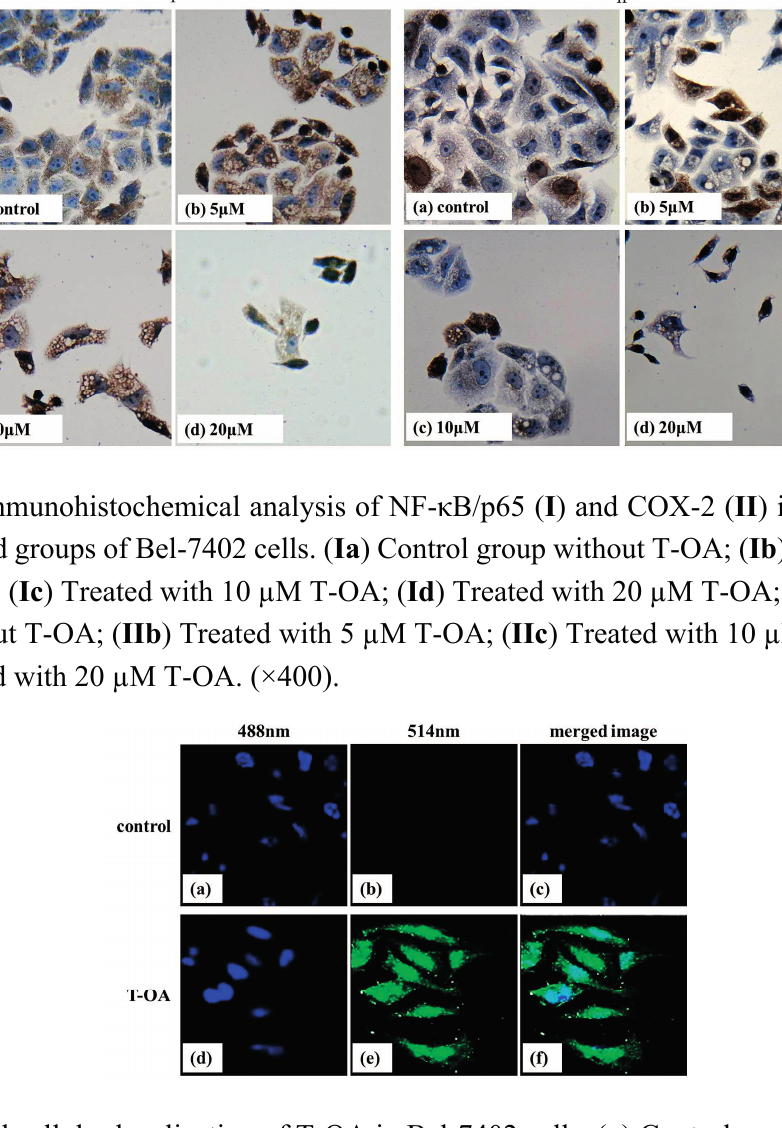
Figure 8. Subcellular localization of T-OA in Bel-7402 cells. ( a ) Control group at 488 nm; ( b ) Control group at 514 nm; ( c ) Merged image of control group; ( d ) T-OA fluorescent analogue treated group at 488 nm; ( e ) T-OA fluorescent analogue treated group at 514 nm; and ( f ) Merged image of T-OA fluorescent analogue treated group.